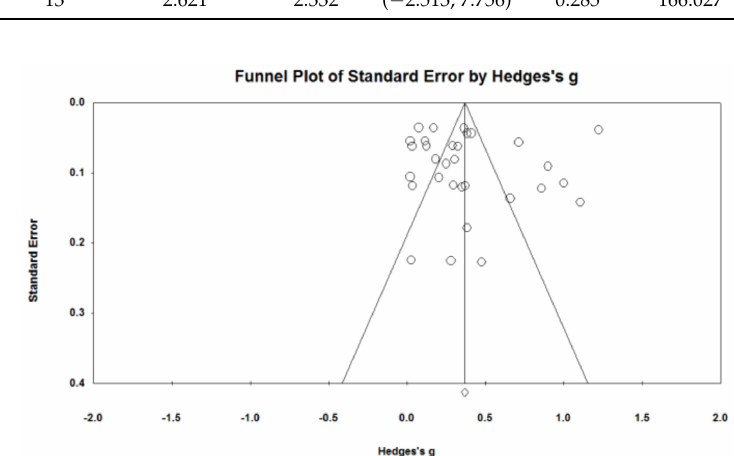
Figure 2. Instantaneous effect volume funnel diagram.